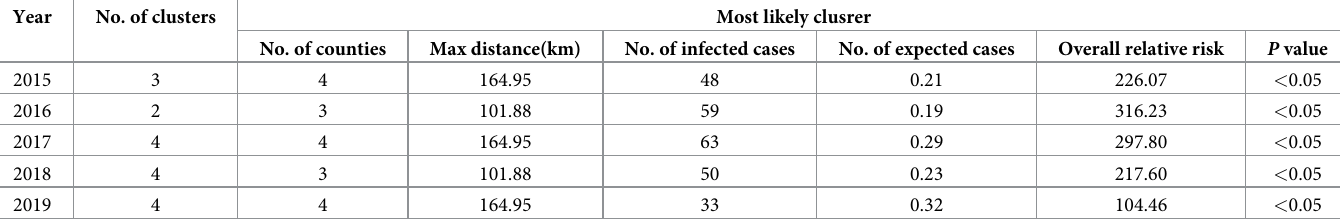
Table 4. Spatial clustering analysis of mountain-type zoonotic visceral leishmaniasis incidence in 6 provences, China from 2015 to 2019. Year No. of